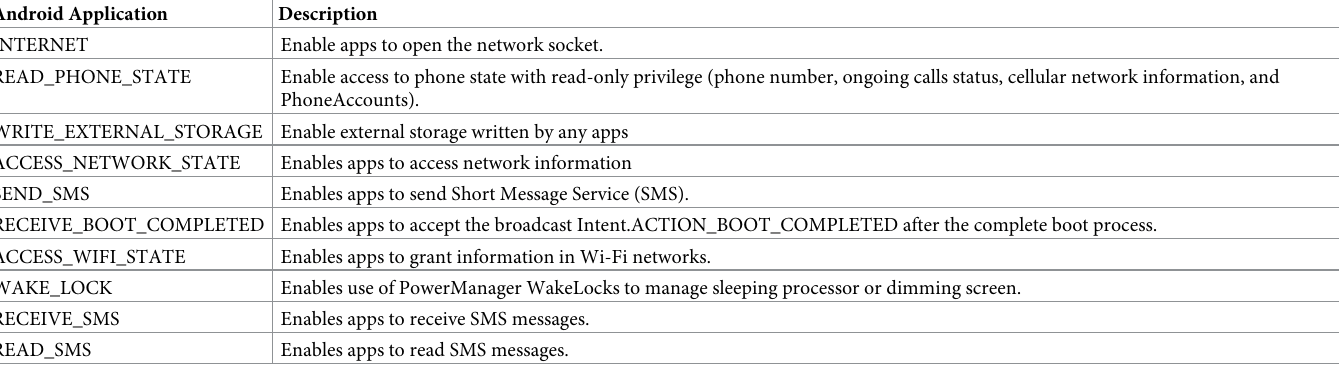
Table 5. Description of the ten highest permission requests by malware applications. Android